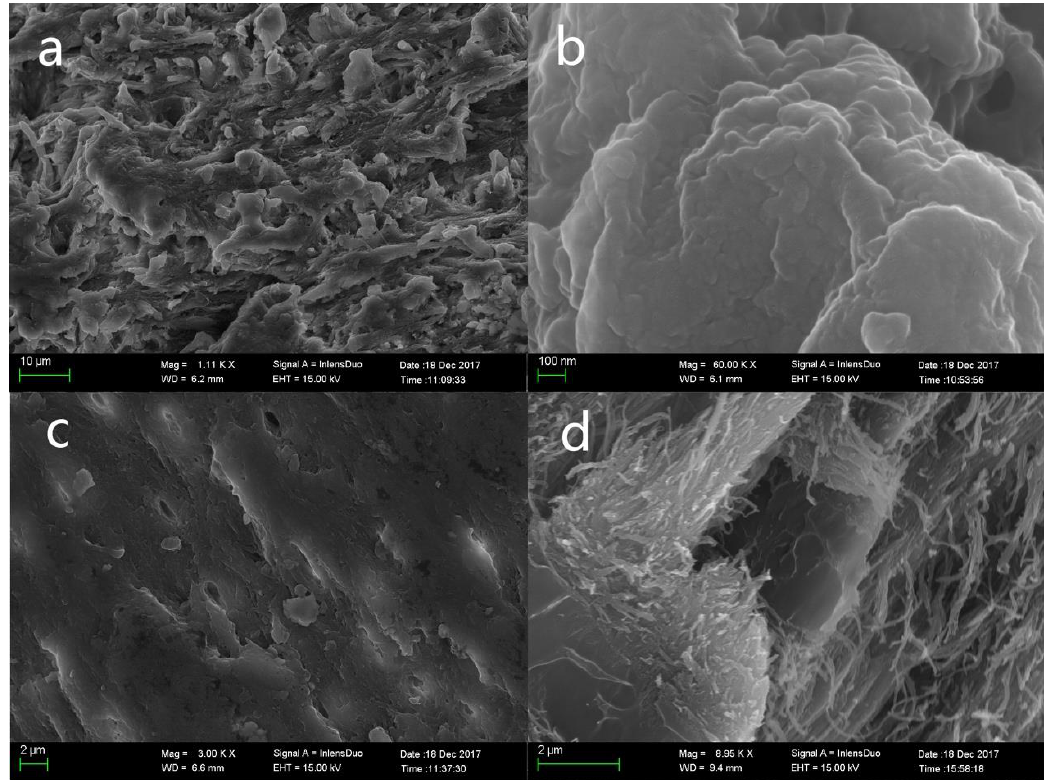
Figure 8. SEM images of the Retzius layer in ivory: ( a ) lamellar structure in radial plane (scale bar: 10 µm), ( b ) tabular hydroxyapatite in radial plane (scale bar: 100 nm), ( c ) tubules run from the central pulp to the periphery of the outmost layer in circumferential plane (scale bar: 2 µm), ( d ) collagen fibrils arranged along perpendicular to the long axes of the tubules in circumferential plane (scale bar: 2 µm).